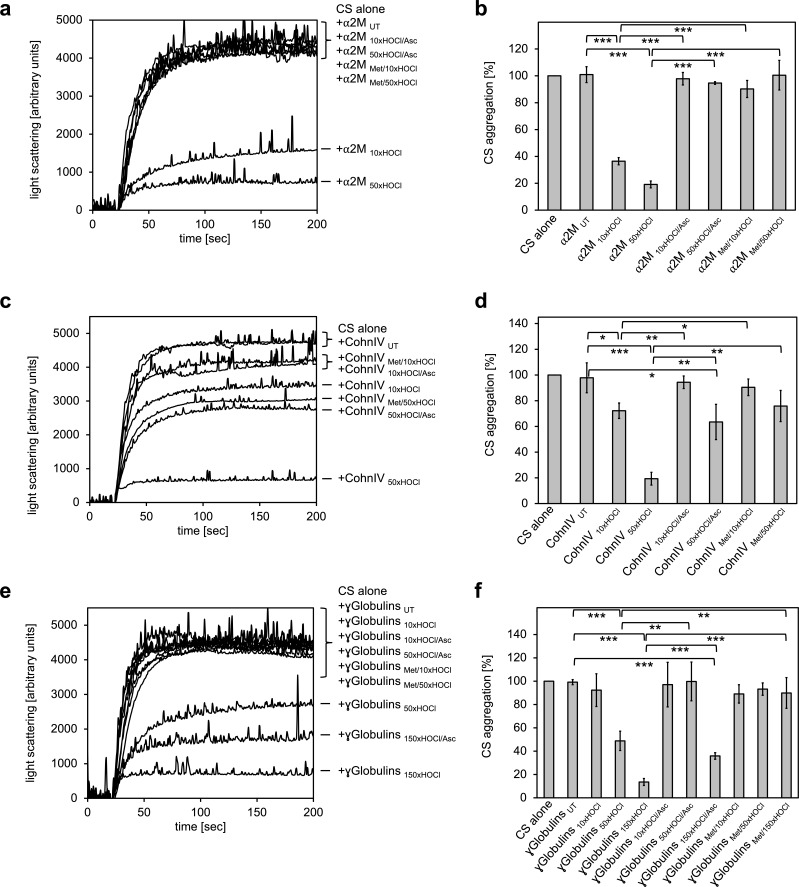
All plasma protein fractions tested exhibit reversible chaperone activity upon modification by HOCl.α2-Macroglobulin (a, b), Cohn fraction IV (c, d) and the γ-globulin fraction (e, f) were analyzed for chaperone activity in a citrate synthase aggregation assay upon treatment with various doses of HOCl. Each plasma protein fraction, when treated with a 10-, 50- or 150-fold molar excess of HOCl, significantly decreased aggregation of chemically denatured citrate synthase as measured by light scattering at 360 nm. Exposure of the various HOCl-treated plasma proteins to the reductant ascorbate significantly decreased or completely inhibited their chaperone function. Methylation of basic amino acid residues prior to HOCl treatment mostly prevented chaperone-like conversion of the plasma proteins. In a, c and e representative measurements are shown. In b, d and f data are depicting means and standard deviations from three independent experiments. Student’s t-test: *p<0.05, **p<0.01, ***p<0.001. Aggregation of citrate synthase in the absence of any plasma protein fraction was set to 100% and all the data are presented as percentage of this control. Labels of aggregation curves are written in the order of the final intensity of light scattering of the respective treatment.
10.7554/eLife.47395.036Figure 5—source data 1.Numerical light scattering data obtained during protein aggregation assays represented in Figure 5a and b.

10.7554/eLife.47395.037Figure 5—source data 2.Numerical light scattering data obtained during protein aggregation assays represented in Figure 5c and d.

10.7554/eLife.47395.038Figure 5—source data 3.Numerical light scattering data obtained during protein aggregation assays represented in Figure 5e and f.